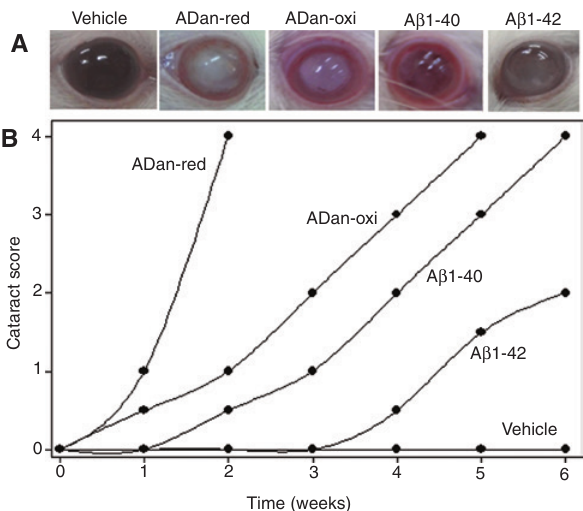
Figure 1: Induction of cataract upon intravitreal injection of demen- tia peptides. (A) Representative photographs of the lens from each group. (B) Quantitative representation of cataract progression in each group with time. Stage of cataract in each group was averaged at a given time and plotted as a function of time (n = 7).